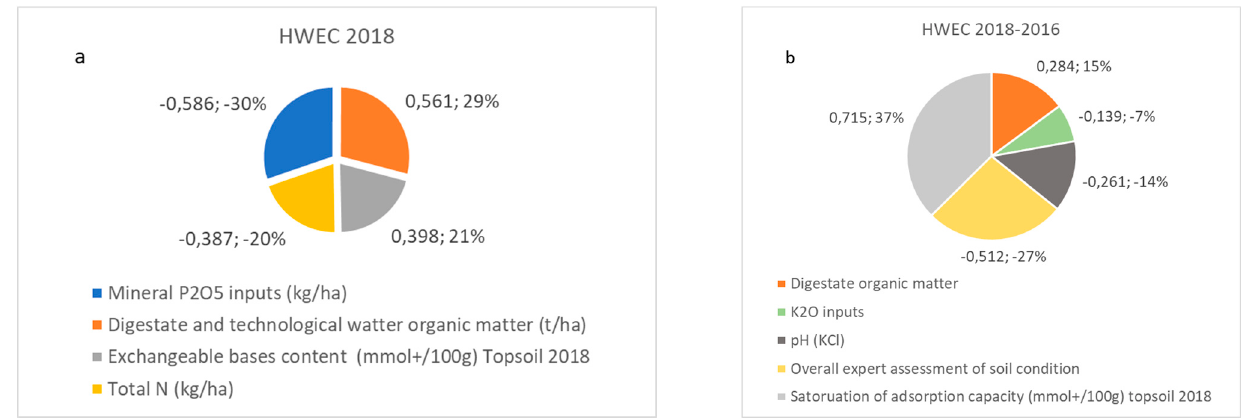
Figure 8. Importance of variables for model ( a ) HWEC 2018 and ( b ) HWEC Difference 2018–2008, (inputs 2016–2018). The humus (SOC) is affected by the HWEC increase (17%)—the organic matter from the HWEC (a labile form of C) has been transformed into the SOC (a stable form of C); see Figure 9.